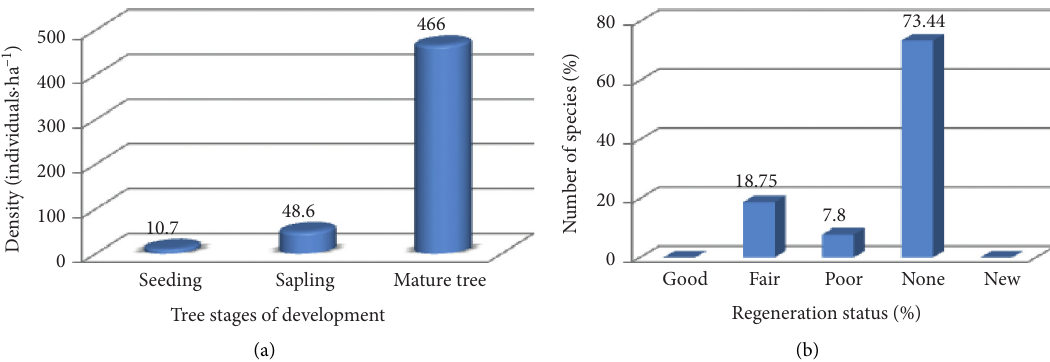
Figure 10: Density of seedling, sapling, and mature tree species (a) and regeneration status (b) of woody plants in Kafta Sheraro National Park Forest.